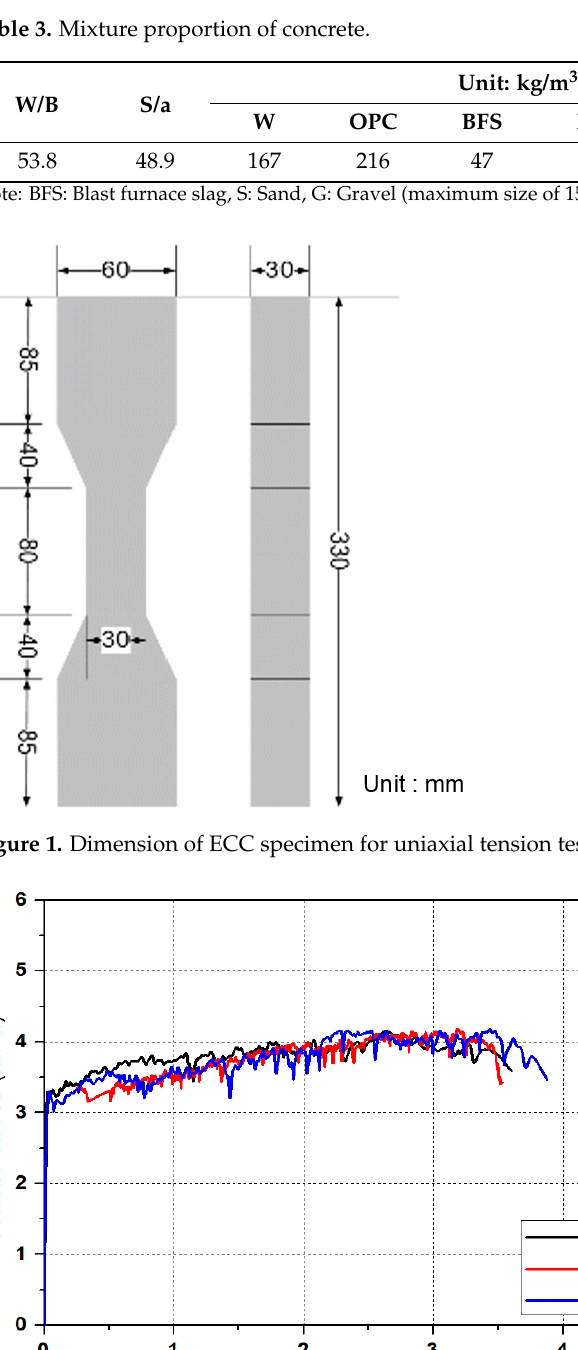
Figure 2. Tensile stress-strain curves of ECC.